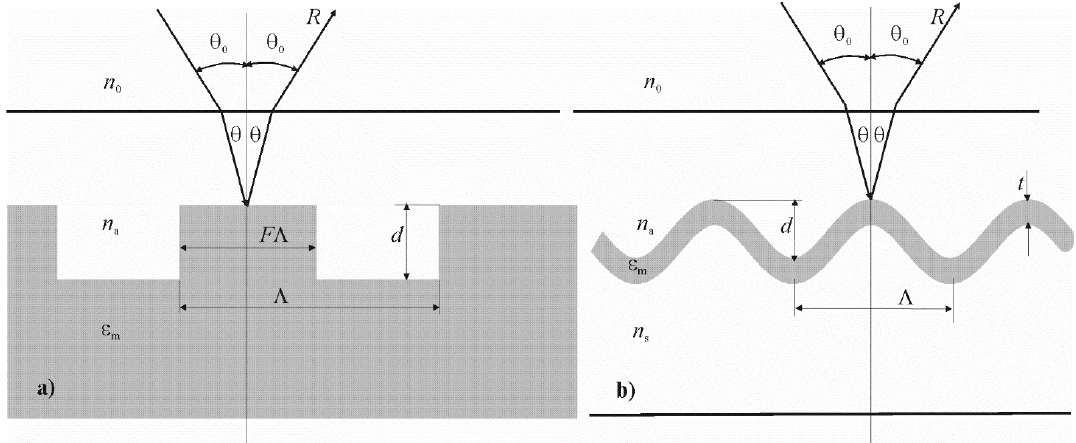
Figure 1. The scheme of periodical structures, where surface plasmon–polariton resonance can be realized: Λ is the grating period, ε m is the dielectric permittivity of the metal, n a is the refractive index of the test medium, n 0 is the refractive index of air, θ 0 is the angle of the beam propagation in air, θ is the angle of the beam propagation in the test medium. Rectangular metal or dielectric grating on a metal substrate, where F is the fill factor, d is the grating thickness ( a ). Relief grating, where the dielectric-metal boundary changes according to a sinusoidal law, where d is the thickness of the metal layer, A is the amplitude of the sinusoidal relief, n s is the refractive index of the substrate ( b ). If the grating period is equal to 1 µm, the grating thickness is 13.4 nm, and the fill factor F is equal to 0.5, then the plasmon–polariton resonance occurs at a wavelength of 1.0109 µm at normal